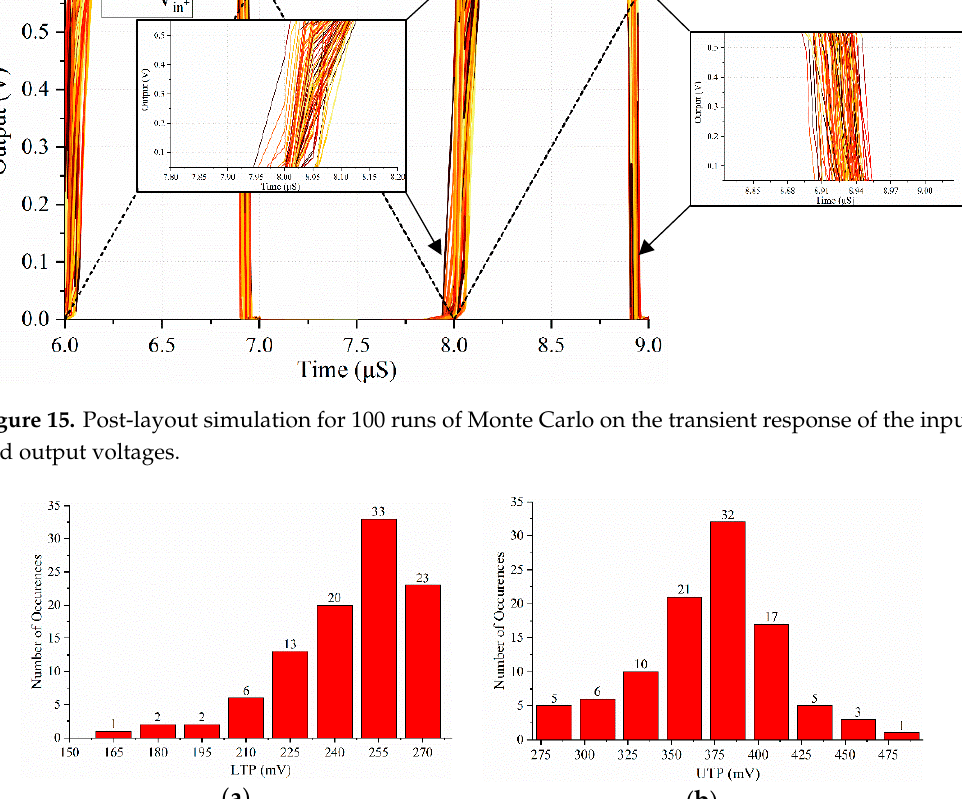
Figure 17. Transient response of the output voltage with ±10% on the power supply for a triangular saw-tooth input voltage. 4. Conclusions A low-voltage, low-power differential Schmitt trigger for biomedical applications, which operates at 0.6 V supply voltage and current mode, has been presented in this paper. By applying bias voltages in the range of 0.3 V to 0.6 V to the positive feedback transistors, the hysteresis width of the proposed circuit can be varied from 126 mV to 132 mV, which means that its hysteresis width is adjusted by the body bias technique. Moreover, by changing the control voltage and reference voltage simultaneously, a bigger range of hysteresis width variation from 45.5 mV to 162 mV is achievable. This Schmitt trigger consumes 1.38 μ W of static power and occupies 10.52 × 7.91 μ m 2 of the chip area. Properties of this circuit make it a good candidate for low-voltage and low-power applications such as electronic healthcare devices and implantable microsystems. Author Contributions: Conceptualization and design, S.R. and A.N.; formal analysis, A.N. and S.R.; software, A.N. and S.R.; investigation, M.H.M. and Y.B.; writing—original draft preparation, S.R.; writing—review and editing, M.N. and S.H.-H.; supervision, P.A. and M.H.M.; funding acquisition, S.H.-H. and M.N. Funding: This research received no external funding. Conflicts of Interest: The authors declare no conflicts of interest. References 1.